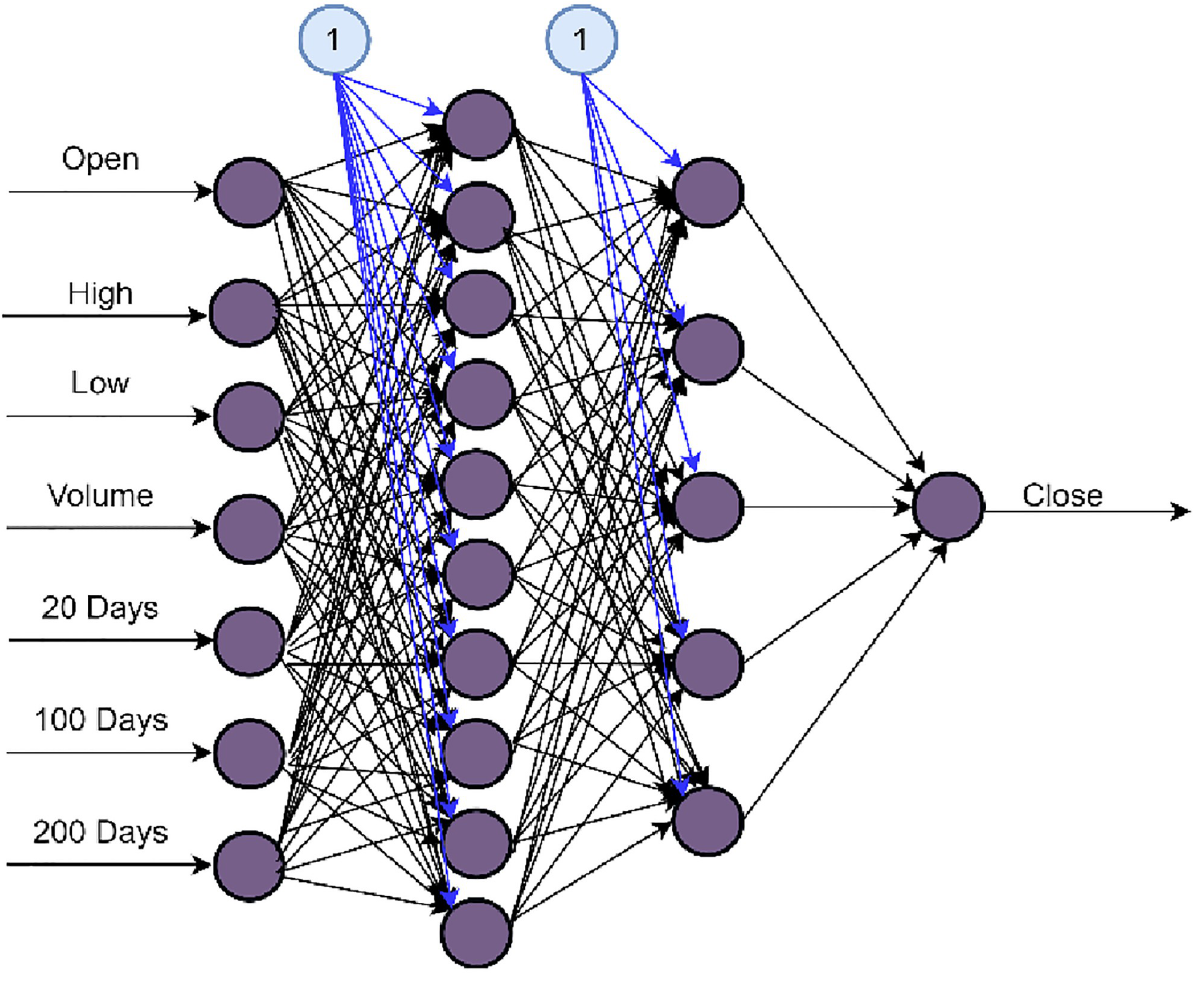
Fig 10. GRU method.